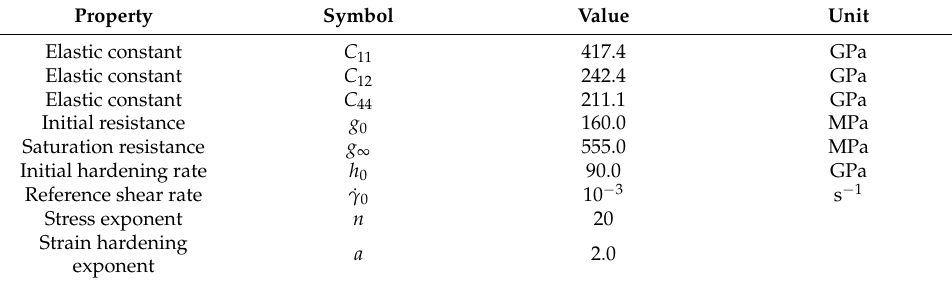
Figure 4. ( a ) Inverse Pole Figure (IPF) map of the experimental microstructure after cleaning. ( b ) Experimental and simulated stress–strain and hardening rate curves. Table 2. Adjusted material parameters, based on